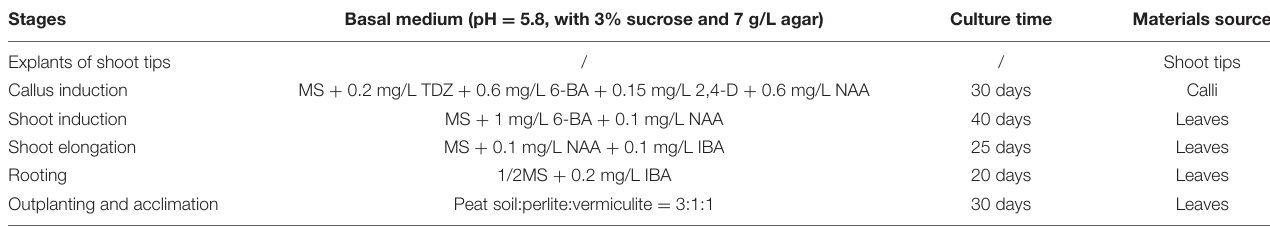
TABLE 1 | Media formulations at various stages and tissues collected for sequencing.